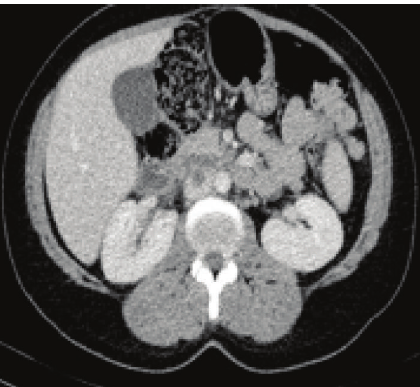
Figure 3: Axial CT; thrombosis in IVC.